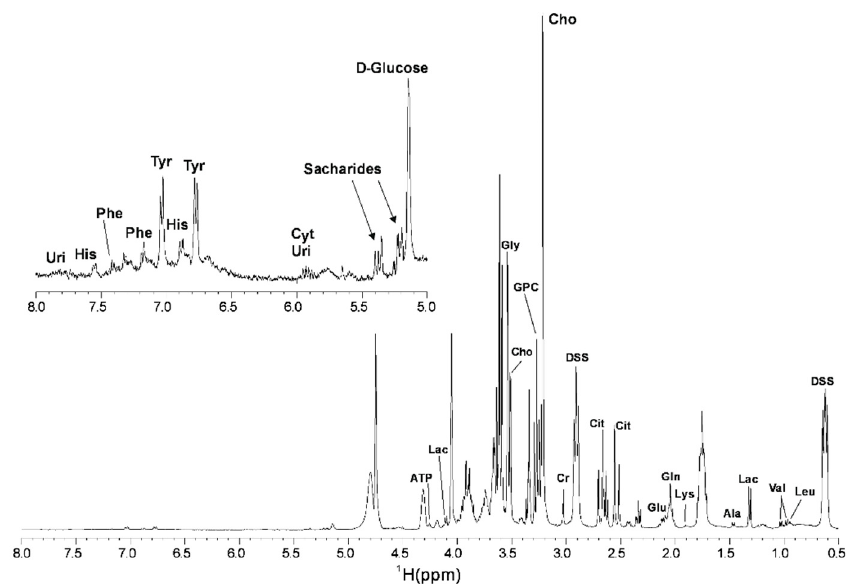
Figure 1. 1 H Nuclear Magnetic Resonance ( 1 H NMR) Carr-Purcell-Meiboom-Gill (CPMG) spectrum of pig seminal plasma in phosphate buffer recorded at 400 MHz and 298 K. Sodium